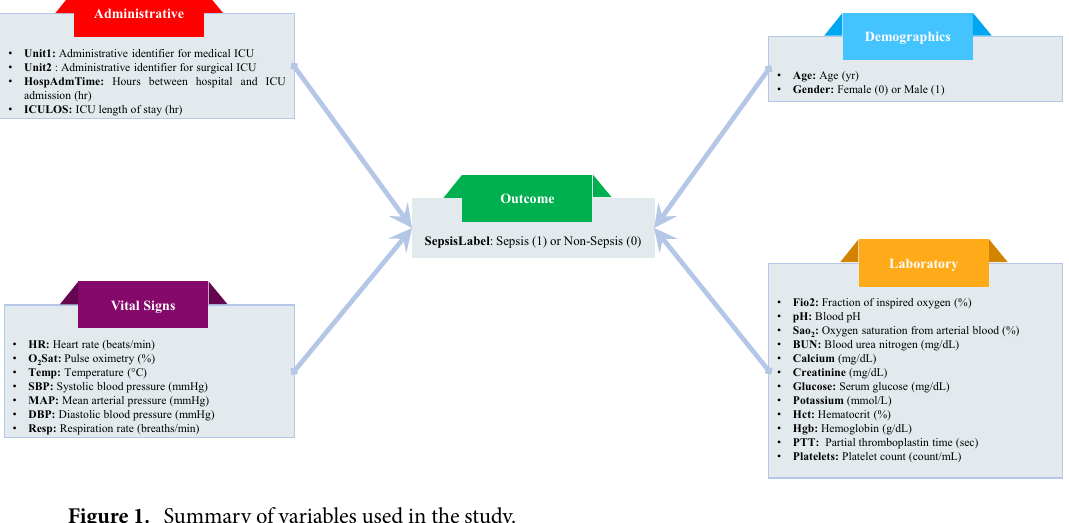
Figure 1. Summary of variables used in the